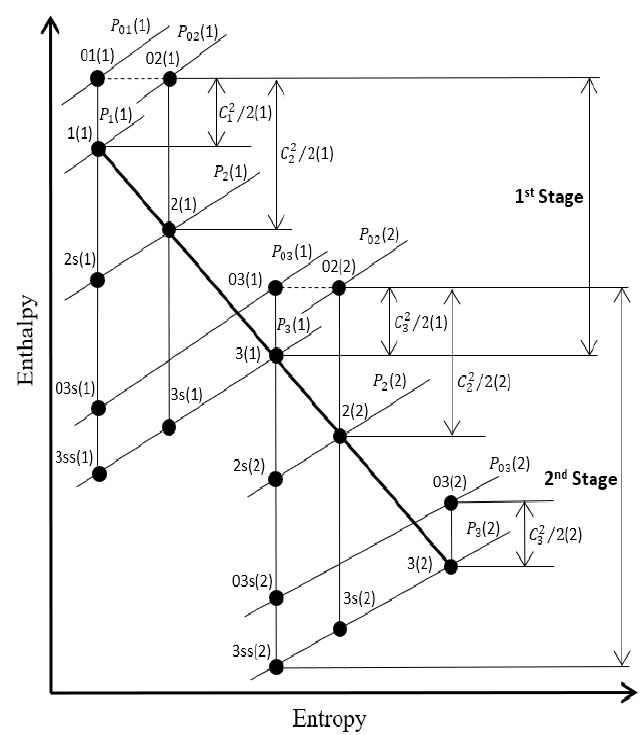
Figure 5. H–S diagram of a two-stage radial outflow turbine.